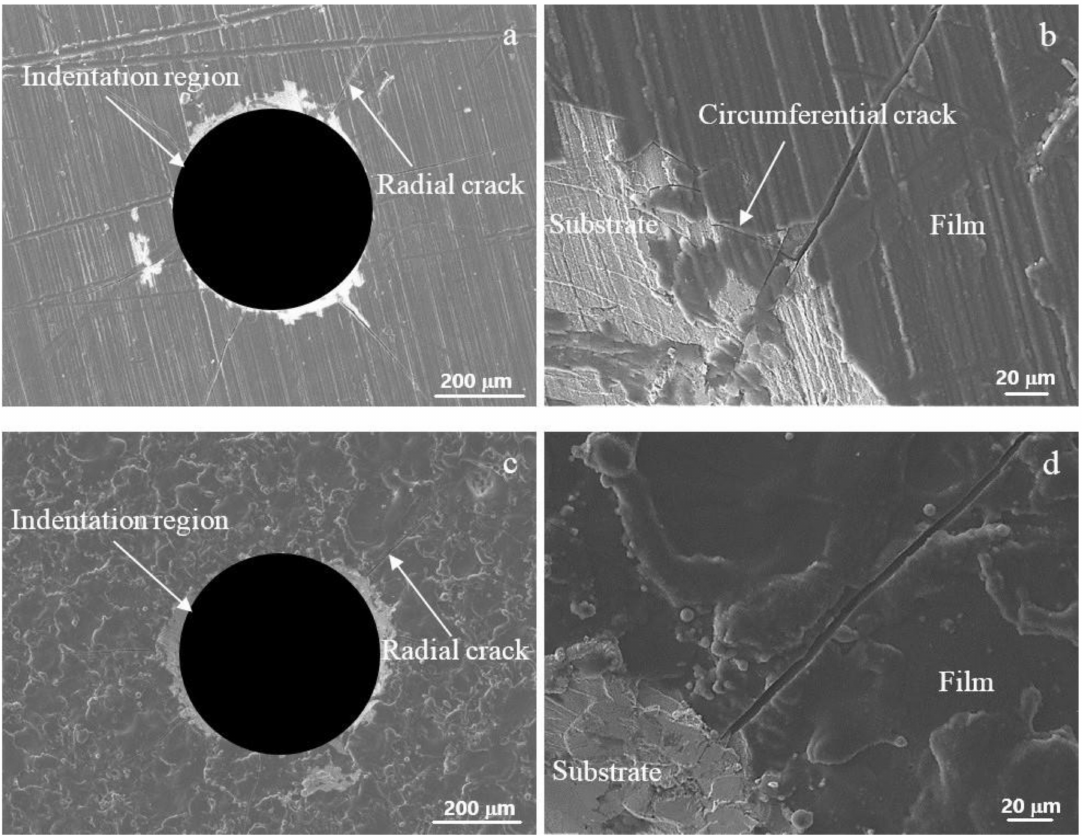
Figure 8. SEM micrographs of the indentations produced by the adhesion test: ( a , b ) for the ground DLC specimen; ( c , d ) for the EDT DLC specimen. ( a , c ) are the indentations and ( b , d ) show selected magnified areas in the vicinity of the indentations.